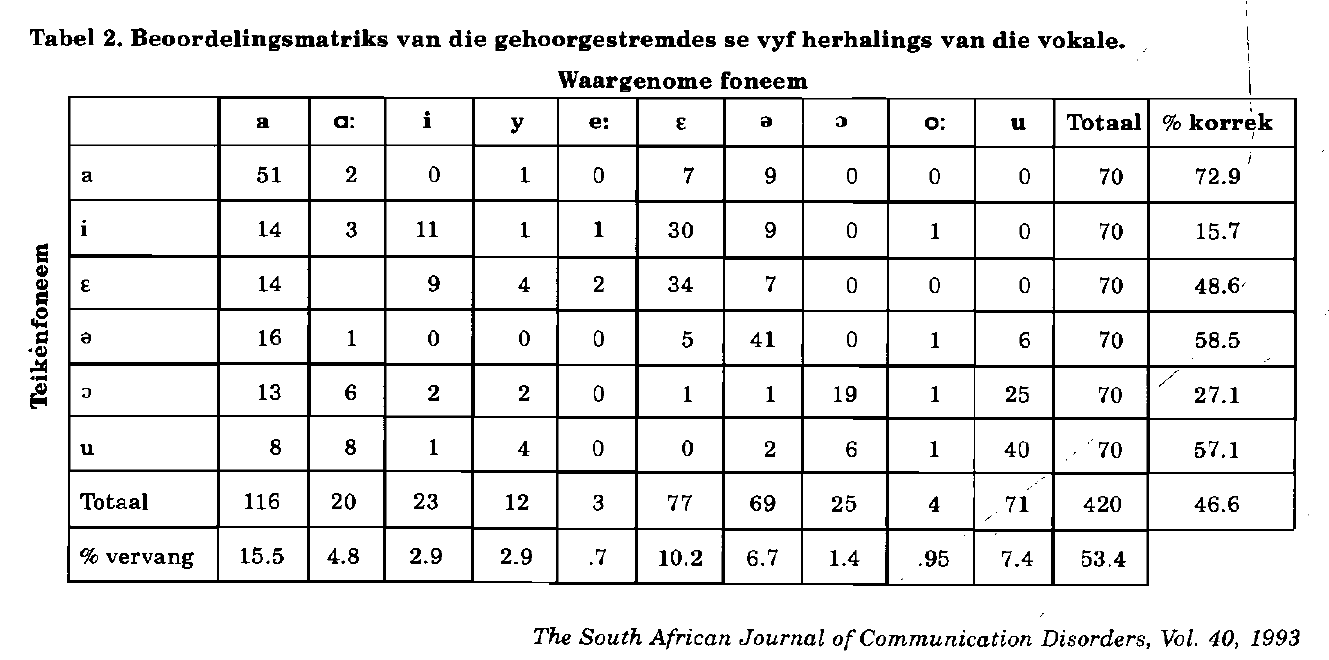
Tabel 2. Beoordelingsmatriks van die gehoorgestremdes se vyf herhalings van die vokale. Waargenome